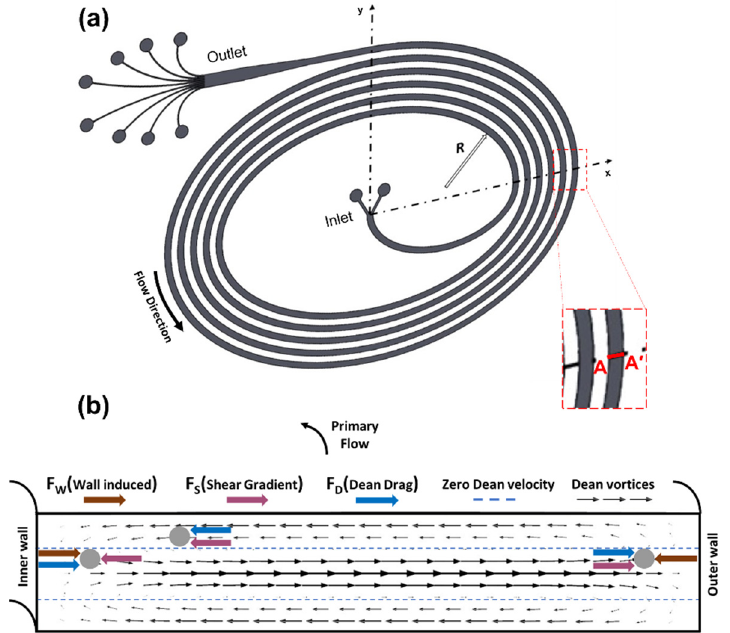
Figure 1. ( a ) Schematic of an elliptic spiral microchannel shown in a Cartesian plane including a radius of curvature, R at a random position, and the location of the A-A’ cross-section. ( b ) A close-up view of the A-A’ plane illustrating secondary flow-induced Dean vortices, zero Dean velocity lines, and a force diagram demonstrating the directions of wall-induced lift force (F W ), shear gradient lift force (F S ), and Dean drag force (F D ) acting on a particle at various locations.